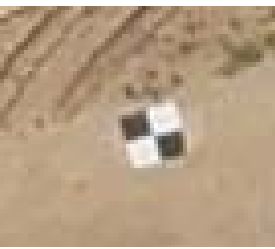
Figure 4. A sample of the signalized ground control points.